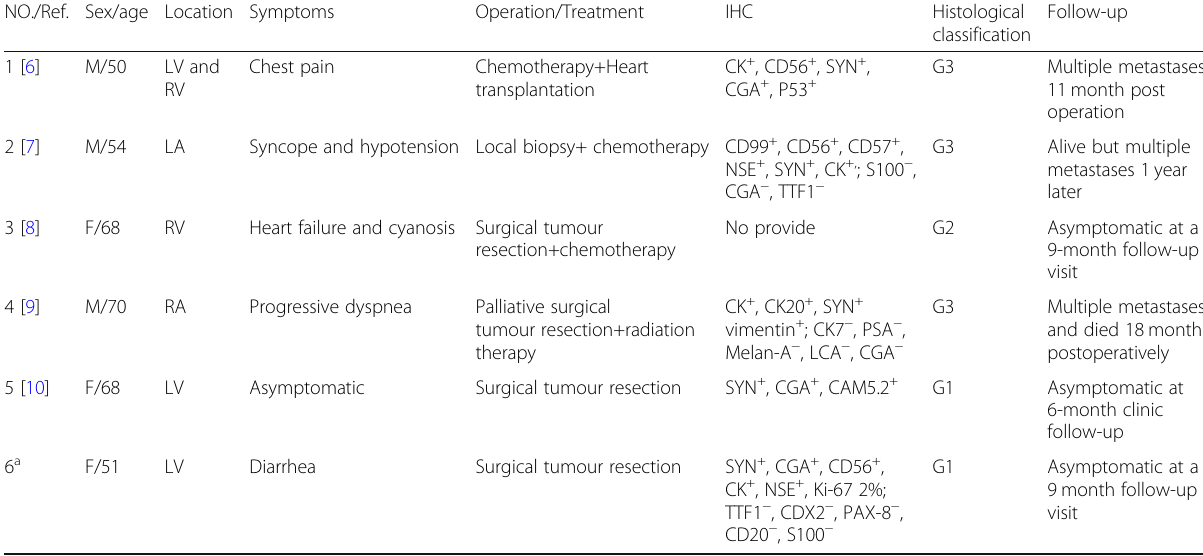
Table 1 Clinicopathologic features of primary cardiac neuroendocrine neoplasms NO./Ref. Sex/age Location